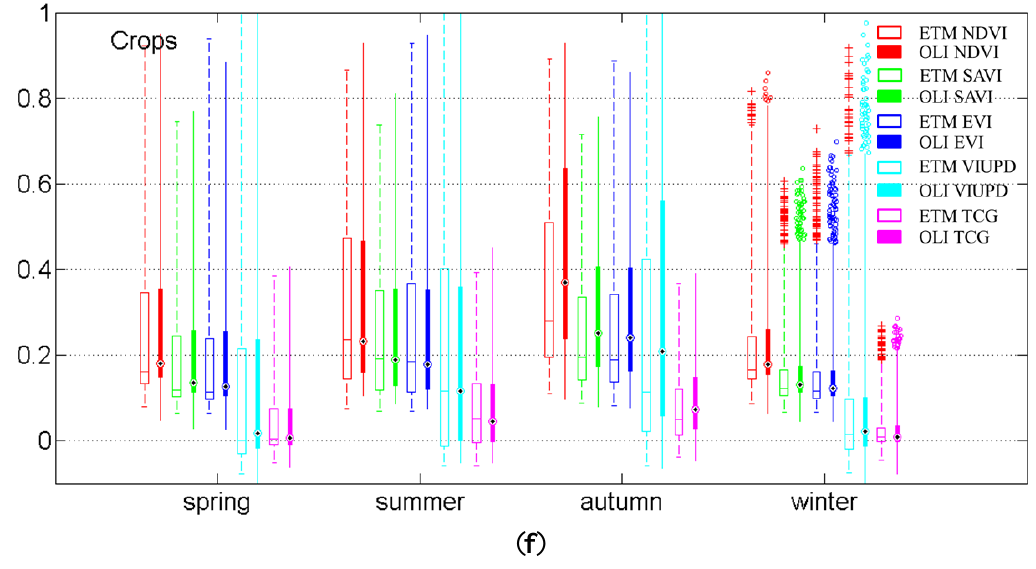
Figure 9. The VIs of various vegetation types during the four seasons based on ETM+ and OLI data. The hollow boxes indicate ETM+ -derived VIs and the solid boxes indicate OLI-derived VIs. The five VIs are shown in red, green, blue, cyan and magenta. ( a ) Deciduous forest; ( b ) Evergreen forest; ( c ) Mixed forest; ( d ) Shrub; ( e ) Grassland; ( f )